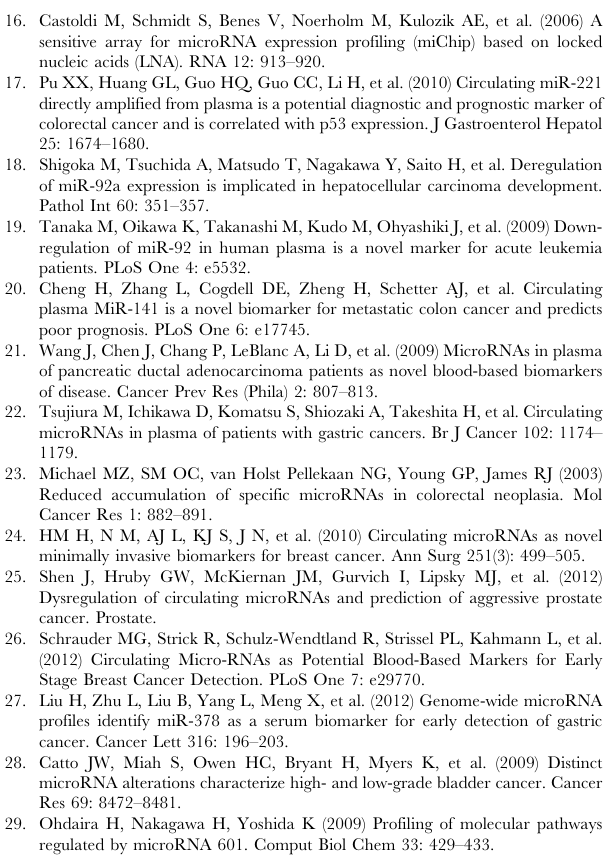
Table S1 Patient information for miRNA profiling. Table S2 Patient information for large scale validation. Table S3 The pathological features of advanced adeno- mas. Table S4 Patient information for validation of paired CRC tissues. Table S5 miRNAs deregulated in CRC plasma with FC .